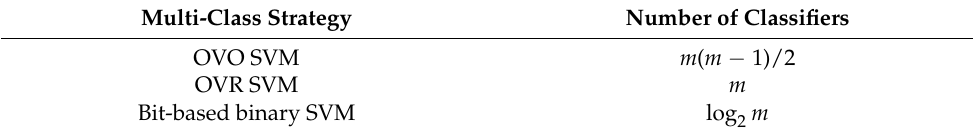
Table 1. The number of required classifiers for different multi-class